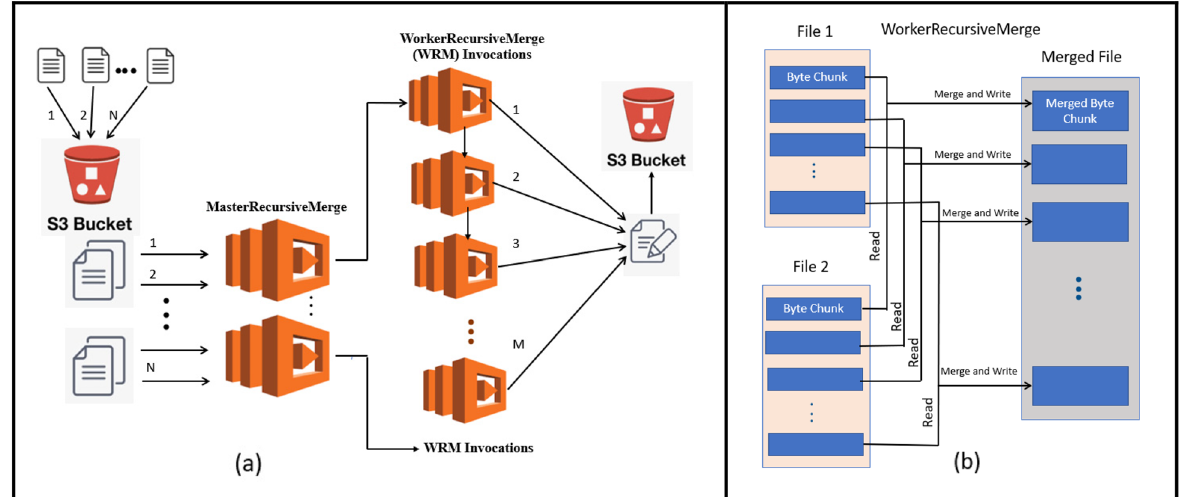
Fig. 8 a Parallel Reactive Merge b Worker Recursive